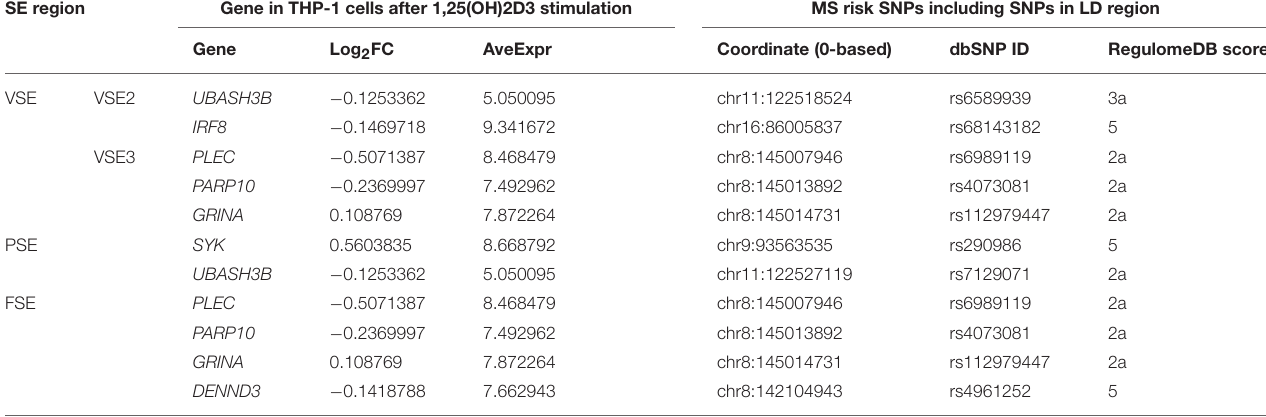
TABLE 4 | The gene near SE regions that overlap with MS risk SNPs. SE region Gene in THP-1 cells after 1,25(OH)2D3 stimulation MS risk SNPs including SNPs in LD region